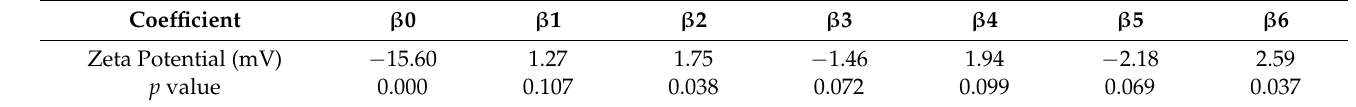
Table 8. Summary of regression coefficient analysis for the response Y2 (Zeta potential).